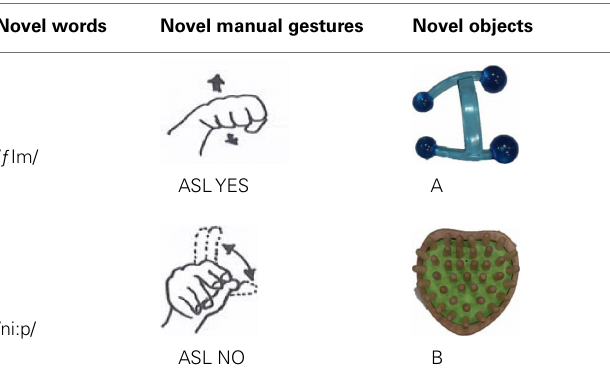
Table 1 | Spoken words, manual gestures, and novel objects used in this study.